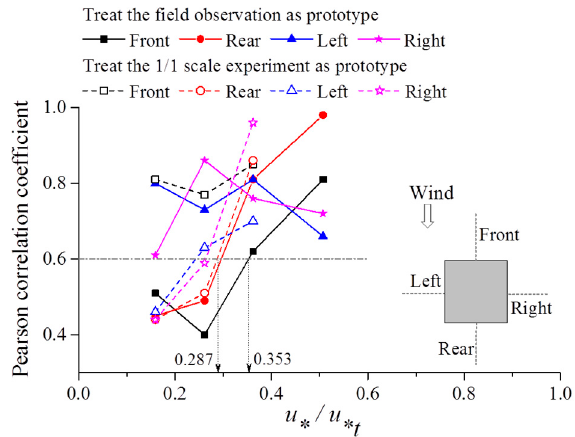
Figure 15. Pearson correlation coefficients of the distribution coefficient between the prototype and scale experiments.